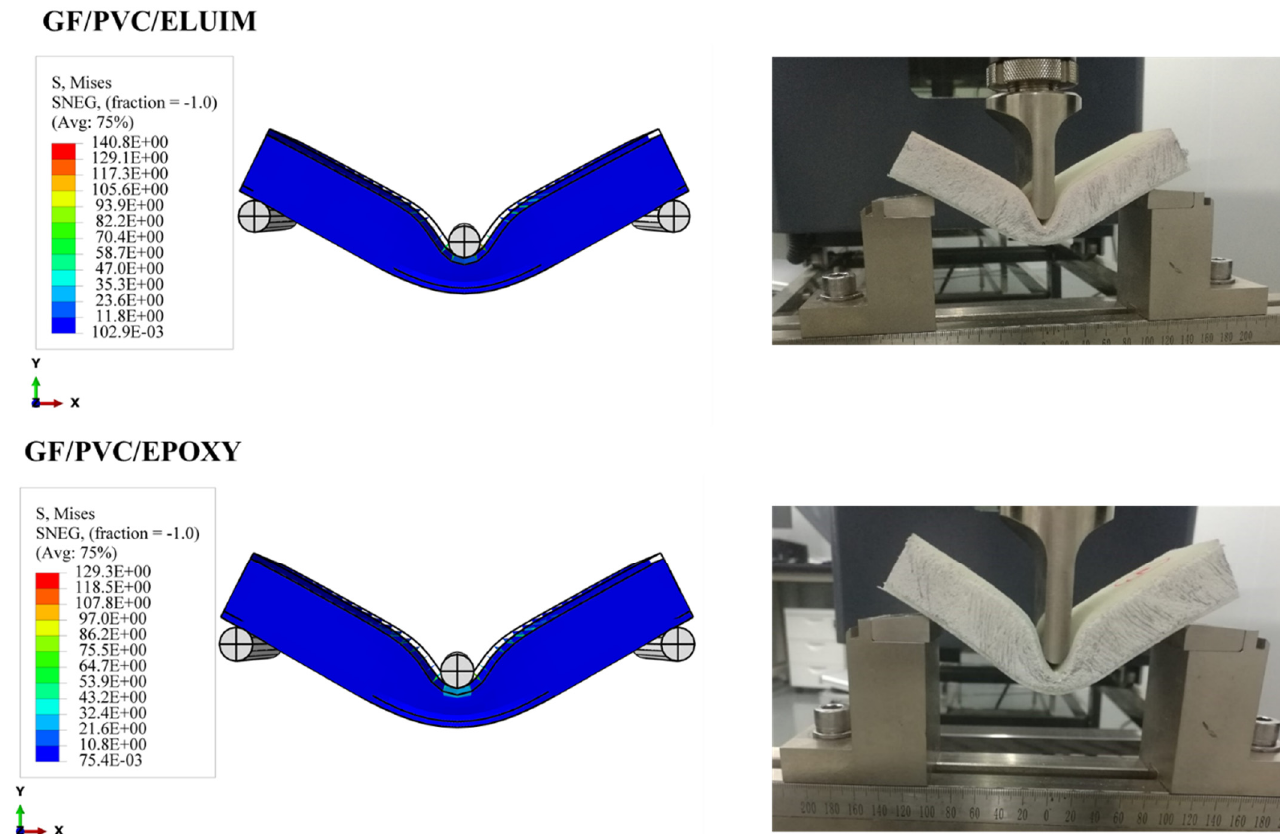
Figure 7. Experimental and numerical damage mechanisms under the flexural load of GF/PVC/Elium and GF/PVC/Epoxy sandwich composites.